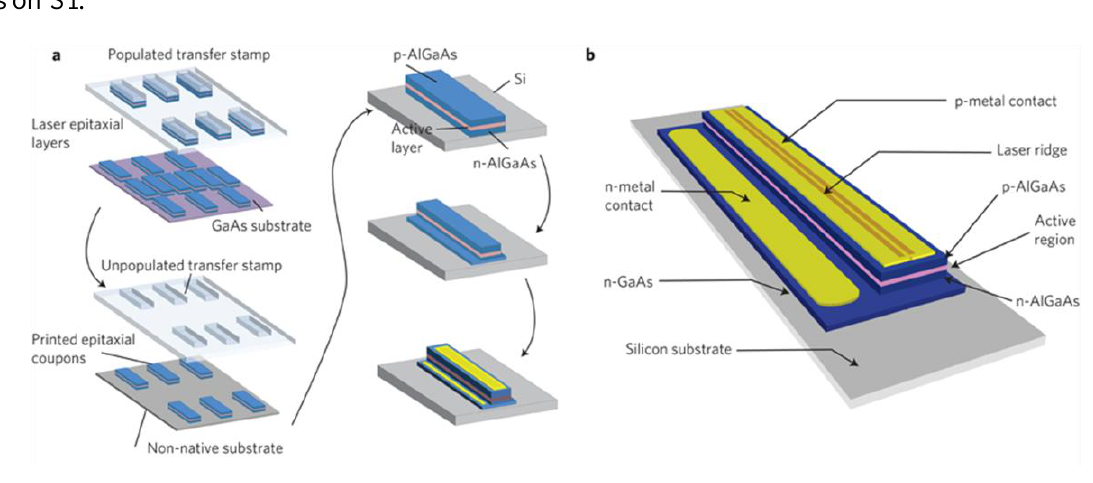
Figure 12. ( a ) Schematic of the transfer of unprocessed coupons of epitaxial materials from a native III-V wafer to the host substrate; and ( b ) Schematic of a laser on the silicon substrate. Reproduced with permission from